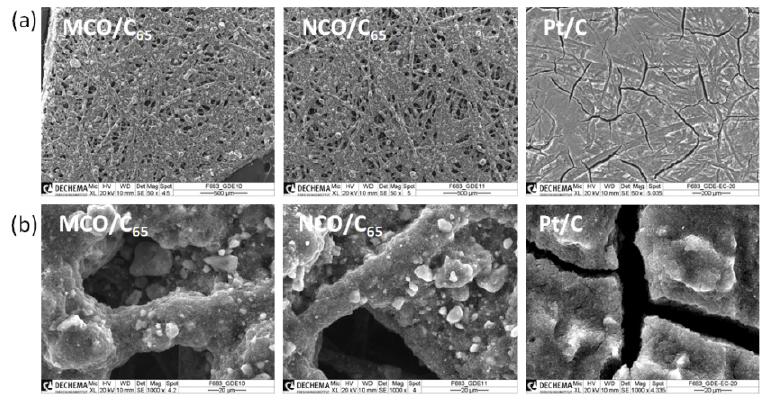
Figure 4. SEM images of different 1 mg catalyst g − 1 GDE surfaces at ( a ) 50× and ( b ) 1000× magnification.